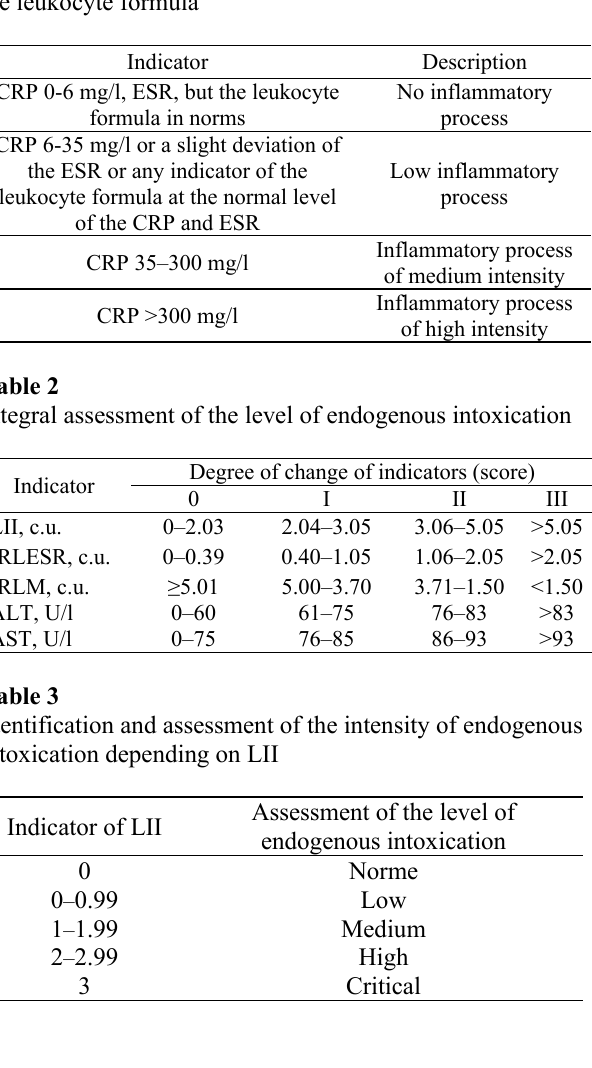
Integral assessment of the intensity of the inflammatory process in dogs in terms of the level of the SRP, ESR and the leukocyte formula